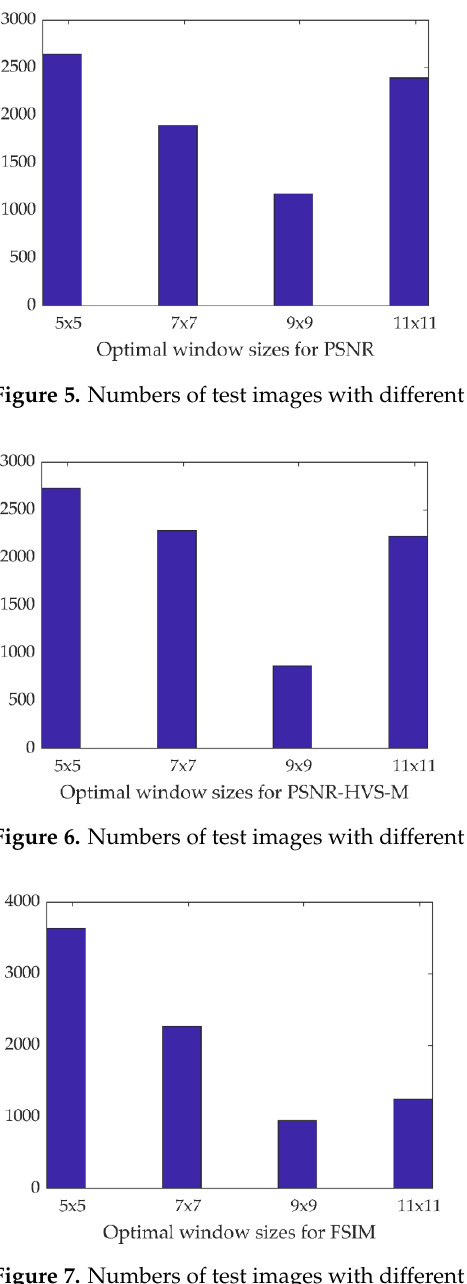
Figure 7. Numbers of test images with different optimal window sizes according to FSIM.